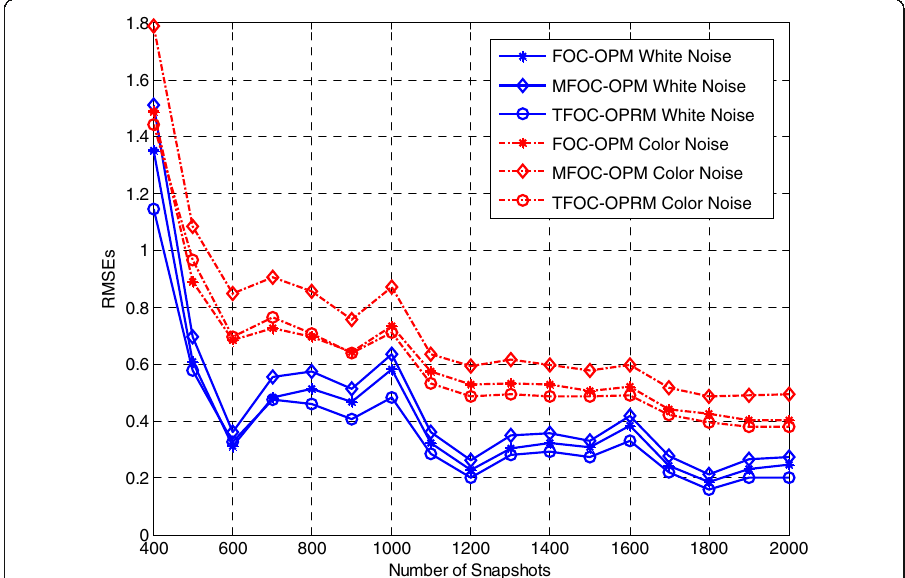
Fig. 4 RMSEs of the DOAs versus